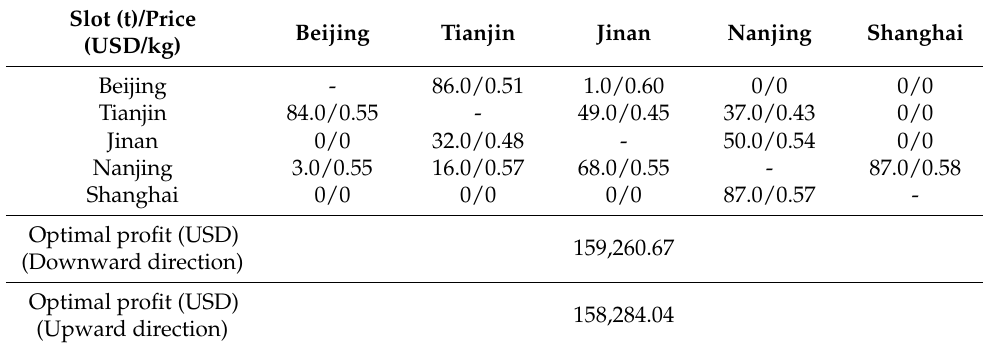
Table 3. The final result of the comprehensive optimization.